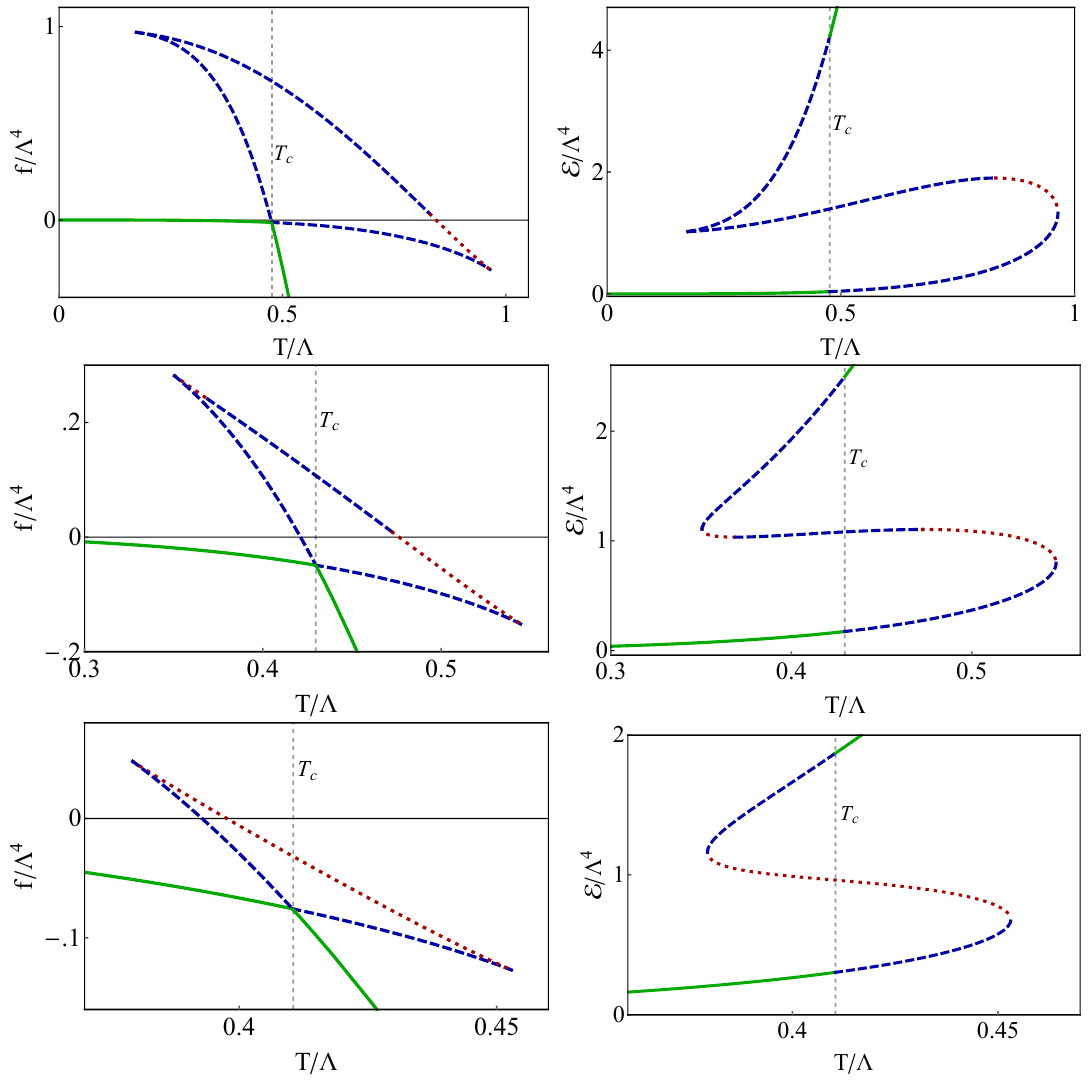
Figure 14 . Free energy (left) and energy density (right) versus temperature for (from top to bottom) (cid:30) M = 0 : 64, (cid:30) M = 0 : 8, (cid:30) M = 0 :